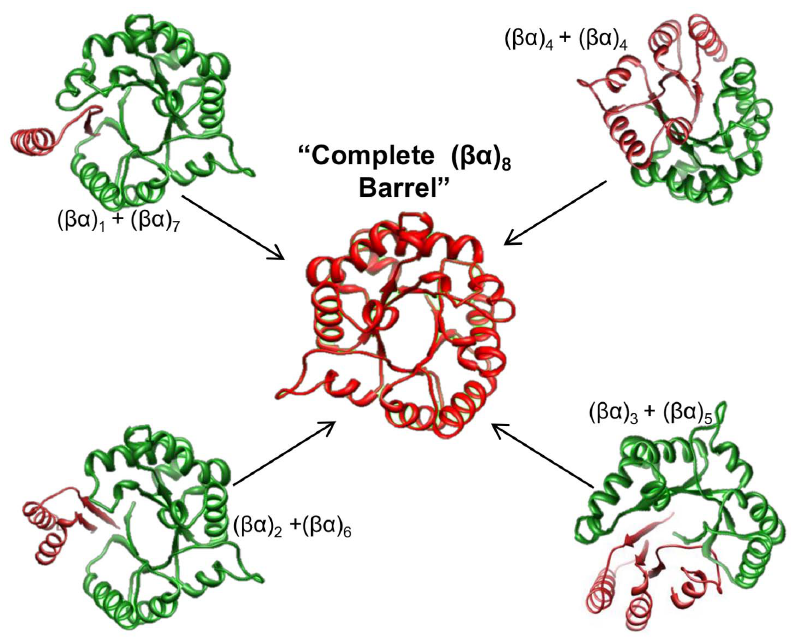
Figure 5. A model of structural assembly of novel ( ba ) 8 barrels by splice variants. According to the experimental evidence of the existence of soluble and stable barrel subdomains in many different ( ba ) 8 barrels, we suggest a process of subdomain assembly through genomic evolution which may result in multiple lineages of novel ( ba ) 8 barrels in the human genome. In addition, the splice variants found in the human genome possibly form homo-dimers, heterodimers, or three-quarter barrel + quarter-barrel complexes to complete the ( ba ) 8 barrel structure. The ribbon diagram shows a representation of the canonical ( ba ) 8 barrel structure, and the different colors correspond to subdomains of different proteins that can be reassembled in the complete barrel (center). This model provides additional support for the proposed models on the origin of the ( ba ) 8 barrel fold through the assembly of smaller subdomains. The 3D structure of PDB 1AW1 was used to illustrate the model.